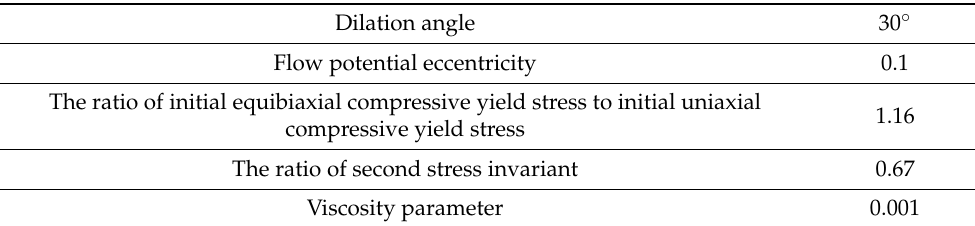
Table 1. Plastic properties of the homogenized